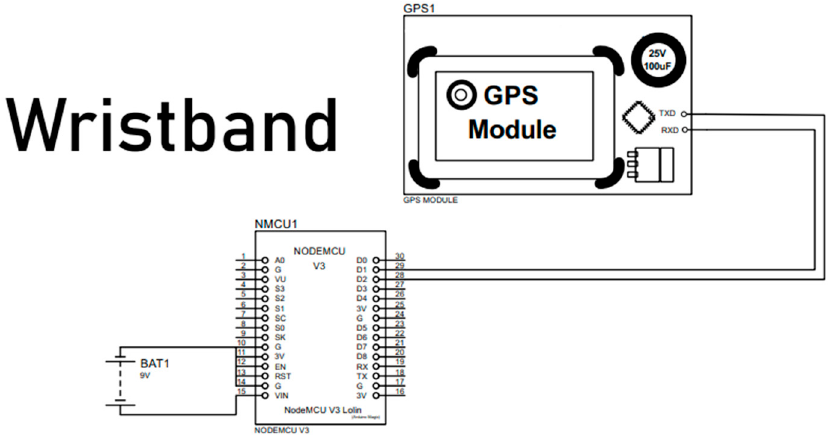
Figure A1. Circuit diagram of GPS and NodeMCU connection in the wristband .